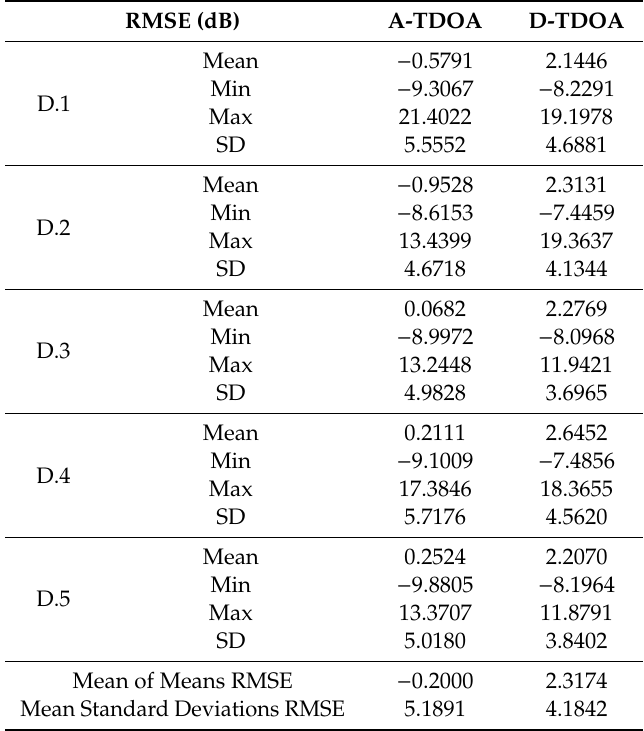
Table 3. RMSE distribution parameters for the five sensor distribution schemes in Table 2 are presented. These data were obtained based on the spatial discretization technique shown in Figures 3 and